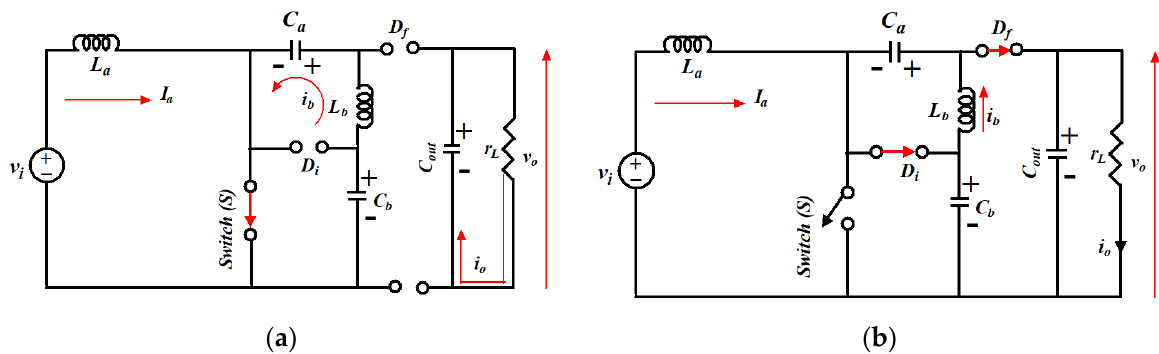
Figure 7. Switching operations of MSEPIC converter: ( a ) during DT; ( b ) during (1 ‐ D)T.